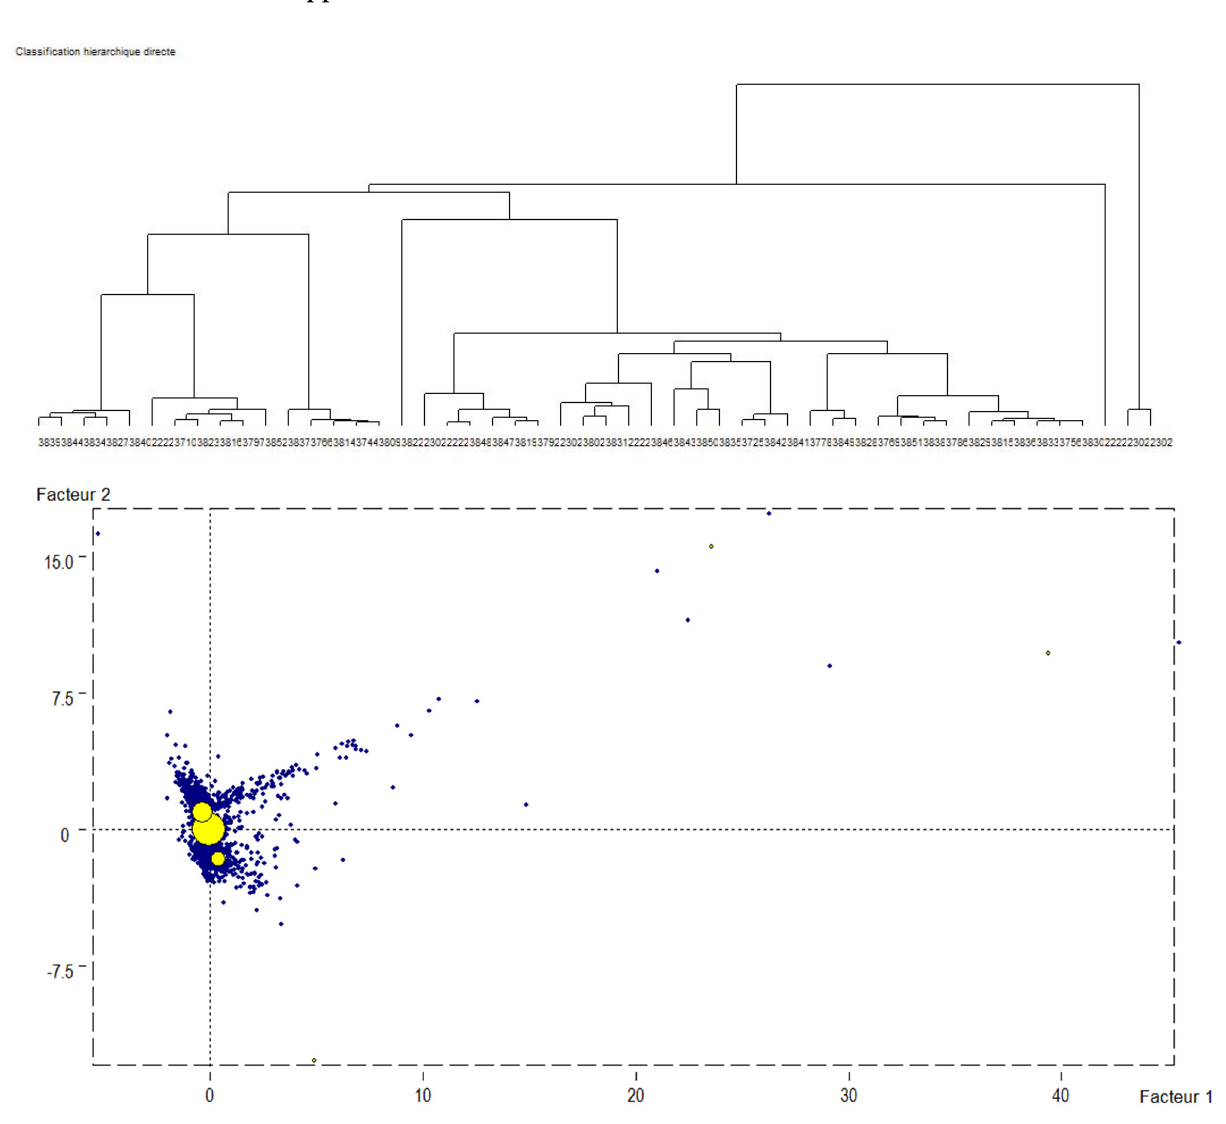
Figure A1. Cluster analysis dendrogram and graph for the northwest geographic distribution.